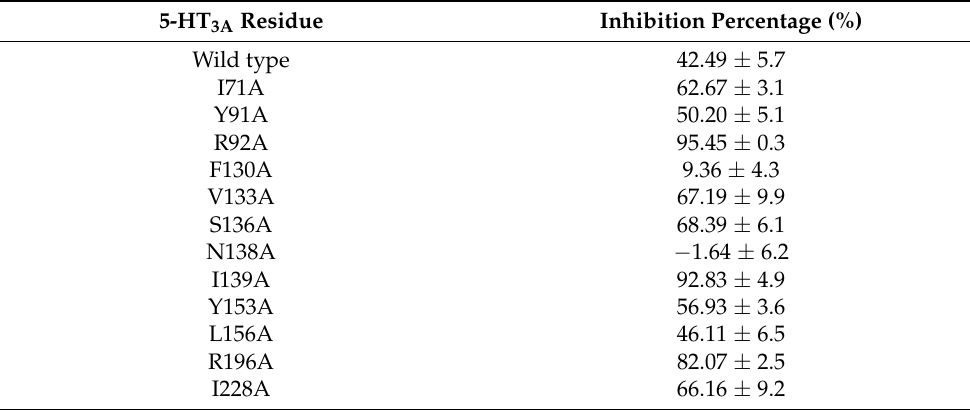
Table 1. Inhibitory effect of 100 µ M chanoclavine on wild-type and mutant